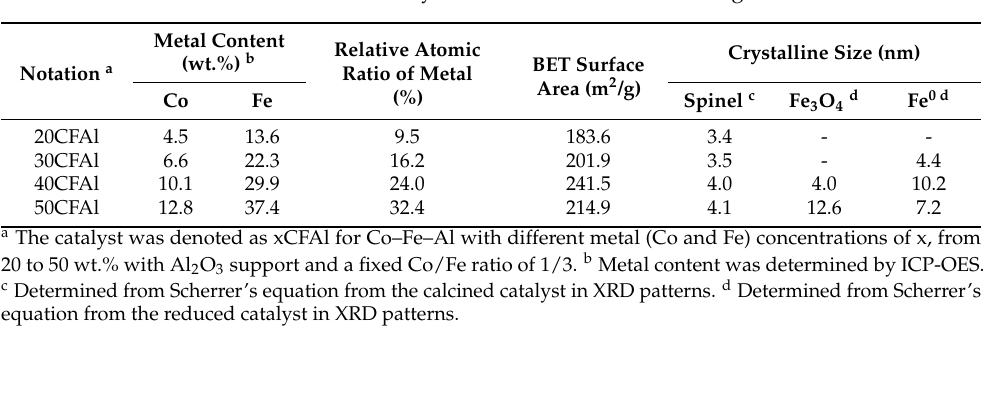
Table 1. Characterization of the CFAl catalysts with different metal